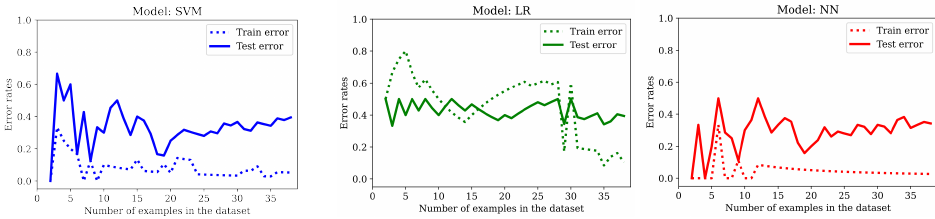
Figure 9. Evolution of errors rates with increasing number of examples in training and testing phase for the original dataset when using regularization. Table 4. Error rates for the original data set when using regularization.